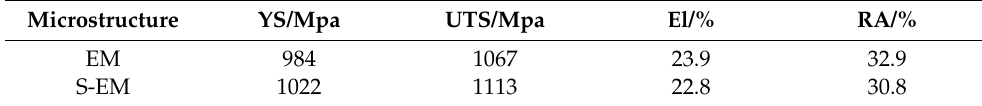
Figure 12. Typical engineering stress–strain curves of the EM and S-EM. Table 3. Tensile properties of EM and S-EM at room temperature.